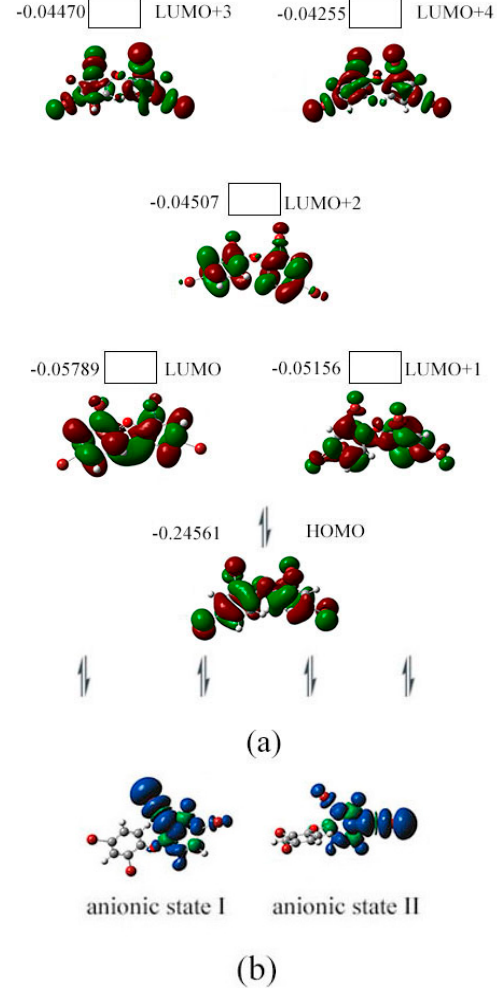
Figure 6. Orbital energy (hartree), HOMO, LUMO ( a , iso-surface value = 0.02 au, degeneracy threshold = 0.01 hartree) for BDE-47 and its spin density ( b , iso-surface value = 0.0004 au) surface image in gas phase.